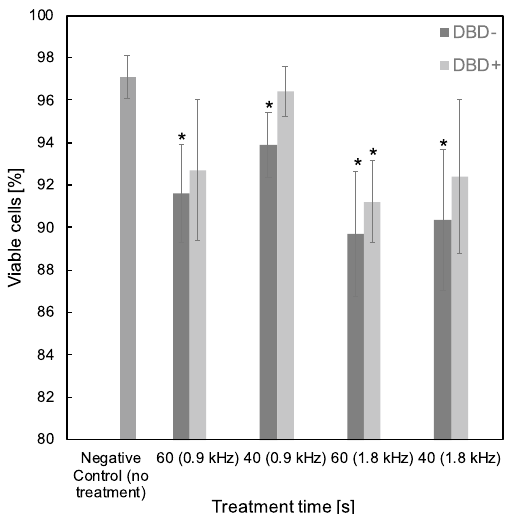
Figure 2. Effects of time, frequency, and polarity on cell viability using the ns-DBD reactor. Results are presented as the mean ± SD (n = 3). Student’s t-test was preformed, and the significance is indicated as * p < 0.05